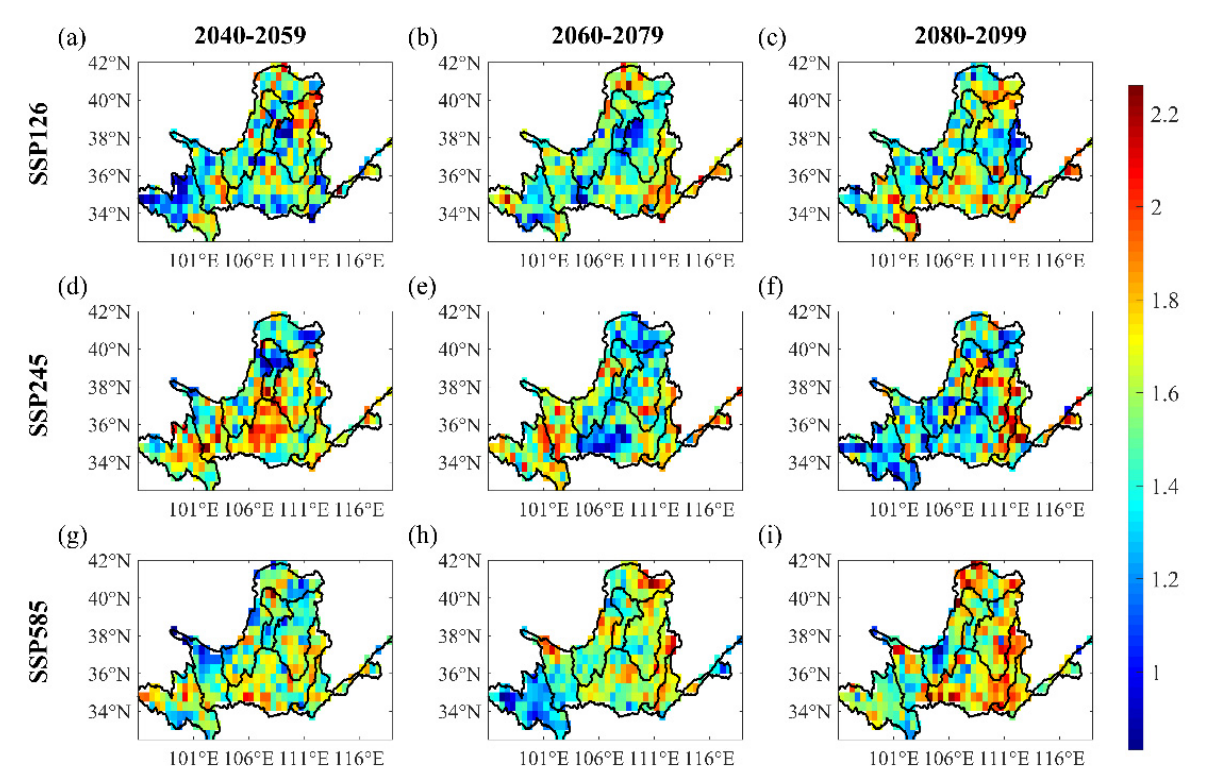
Figure 11. Spatial distribution of drought intensity from SSP126, SSP245, and SSP585 over 2040– 2099 in the Yellow River basin. ( a – c ) are the drought intensity of near future, middle future, far future under SSP126, ( d – f ) are the drought intensity of near future, middle future, far future under SSP245, ( g – i ) are the drought intensity of near future, middle future, far future under SSP585.